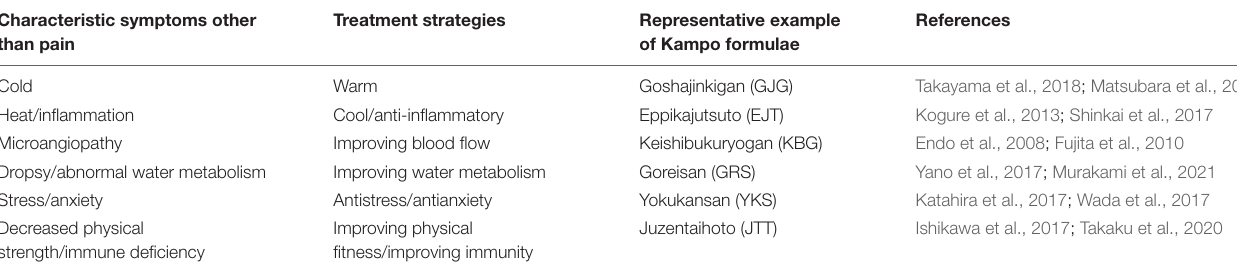
TABLE 1 | Treatment strategies and examples of drug selection in Kampo